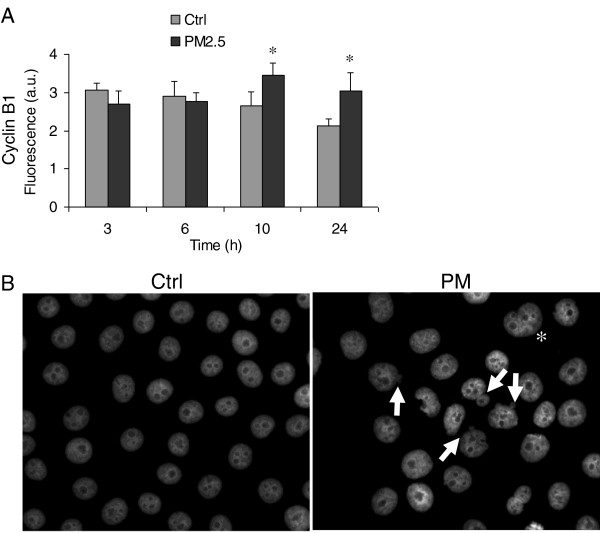
Mitotic process analysis. (A) Cyclin B1 expression was measured by flow cytometry in BEAS-2B cells exposed for 3, 6, 10 and 24 h to 7.5 μg/cm2 of winter PM2.5. The results are reported as fluorescence arbitrary units (mean ± SEM of 3 independent experiments). *Statistically significant difference from untreated cells (control), P < 0.05. (B) Nuclear morphology of BEAS-2B cells exposed for 24 h to 7.5 μg/cm2 of winter PM2.5: fluorescence microscopy illustrating micronucleated (arrows, 18.8% in treated samples vs. 3.2% in controls; statistically significant difference, P < 0.05) and binucleated (asterisk) cells. The results are representative of 3 independent experiments; in each experiment 300 cells were scored.